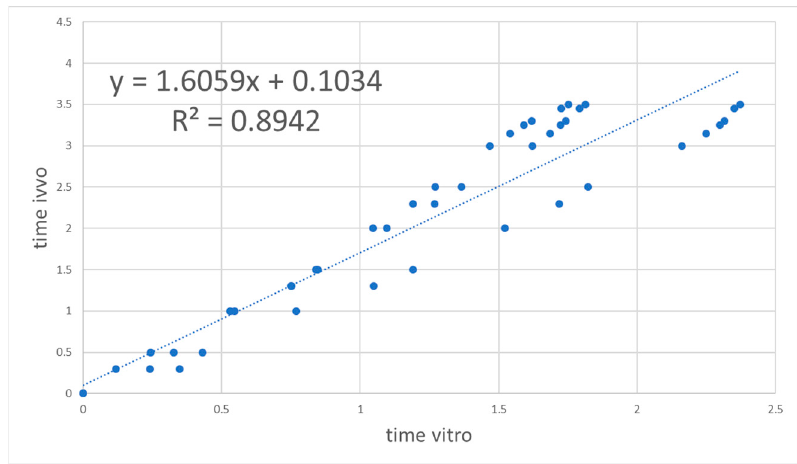
Table 5. Time ‐ scaled Weibull parameters without Test 2 in the Levy plot.